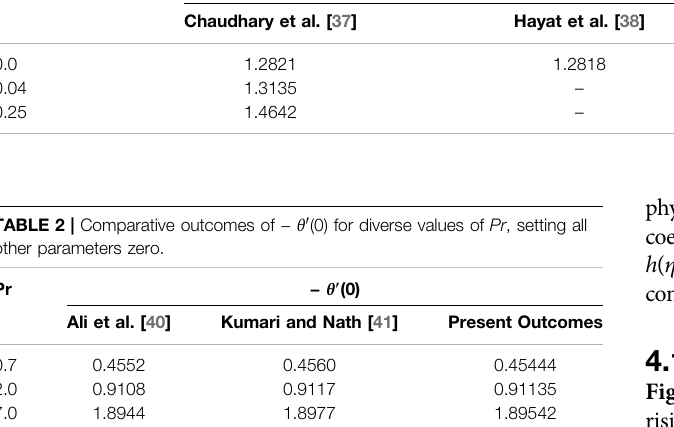
TABLE 1 | Comparative results of − f ″ (0) for diverse values of M , setting all other parameters zero. M